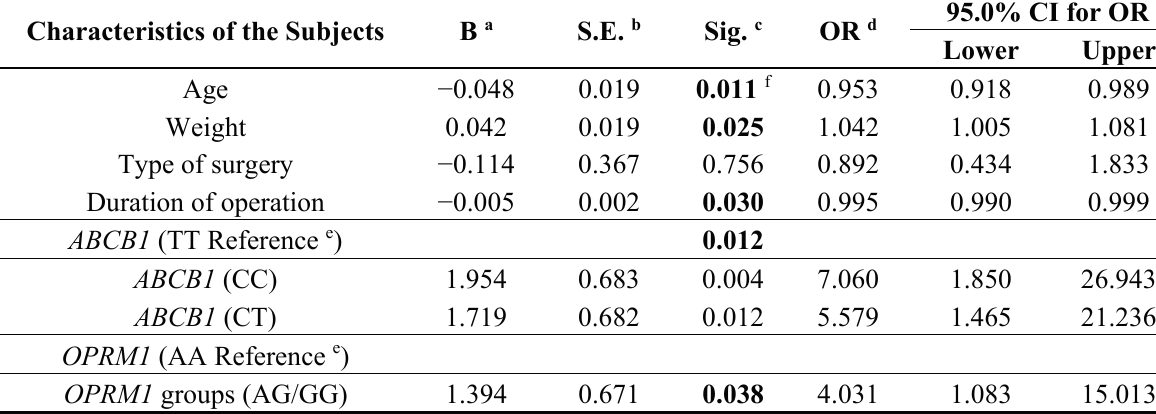
Table 4. Binary logistic regression for morphine dose at 24 h.